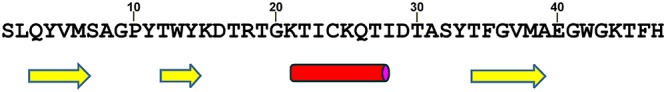
JPred4 prediction of secondary structure formation in LcnB. Yellow arrows: β-strands; Red cylinder: α-helix.